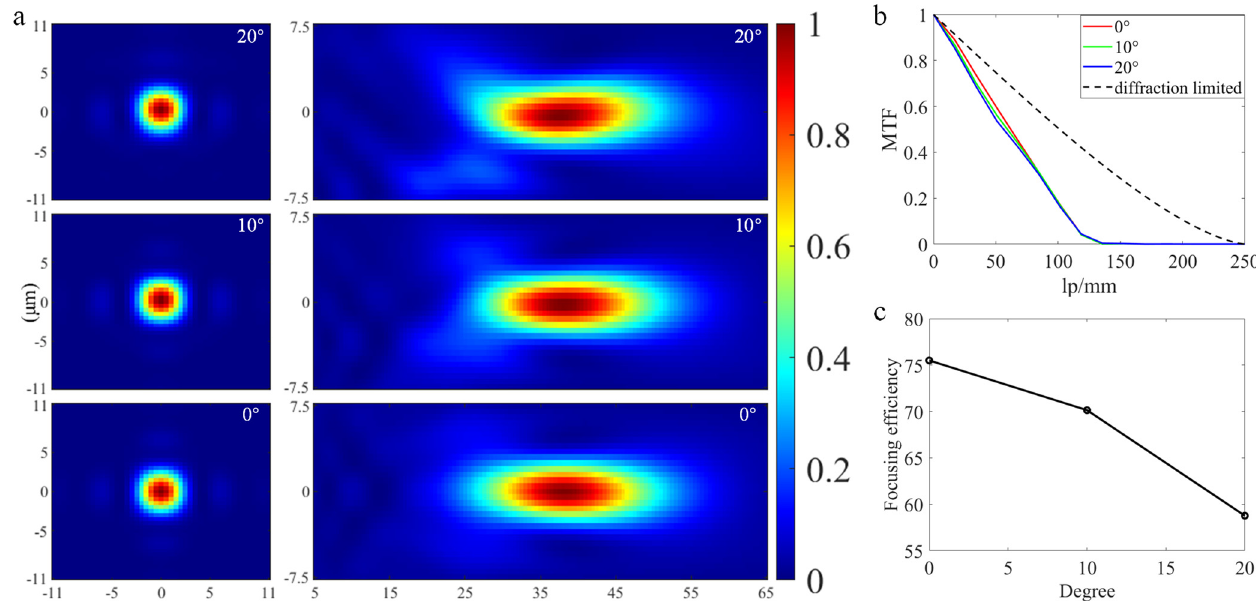
Figure 3. ( a ) Light intensity distribution along XY and XZ direction at each FOV. ( b ) MTF curves at each FOV and the diffraction limit. ( c ) Focusing efficiency at 0°, 10°, and 20° FOV. In the process of manufacturing the metalens, errors will inevitably be introduced.